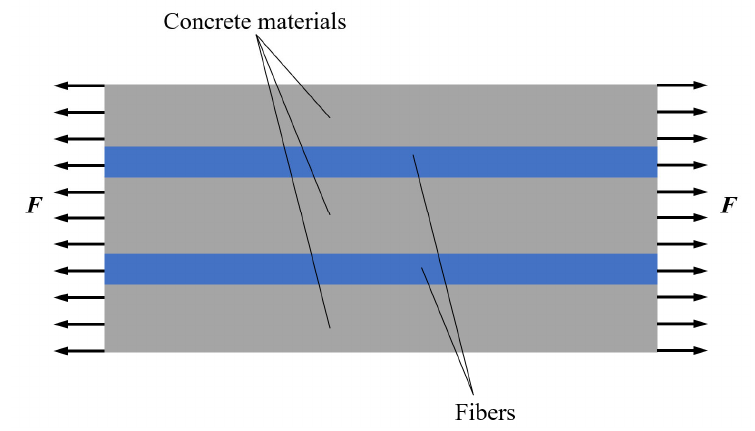
Figure 13. Composite materials force